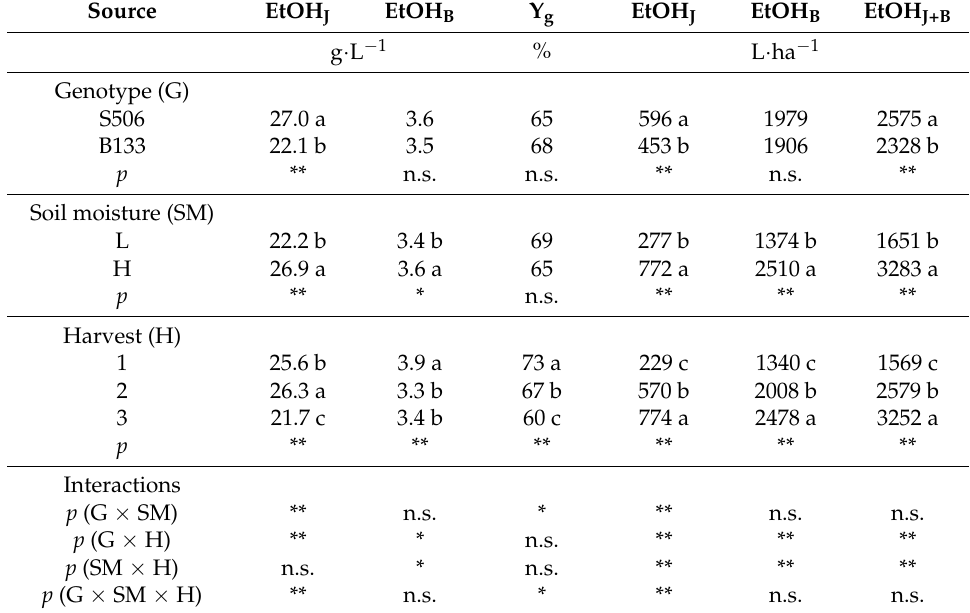
Table 2. Concentration of juice- (EtOH J ) and bagasse-derived ethanol (EtOH B ), and their sum (EtOH J+B ) at the end of fermentation and SSF, respectively, glucose yield in enzymatic hydrolysis (Y g ), and the amount of ethanol on a per hectare